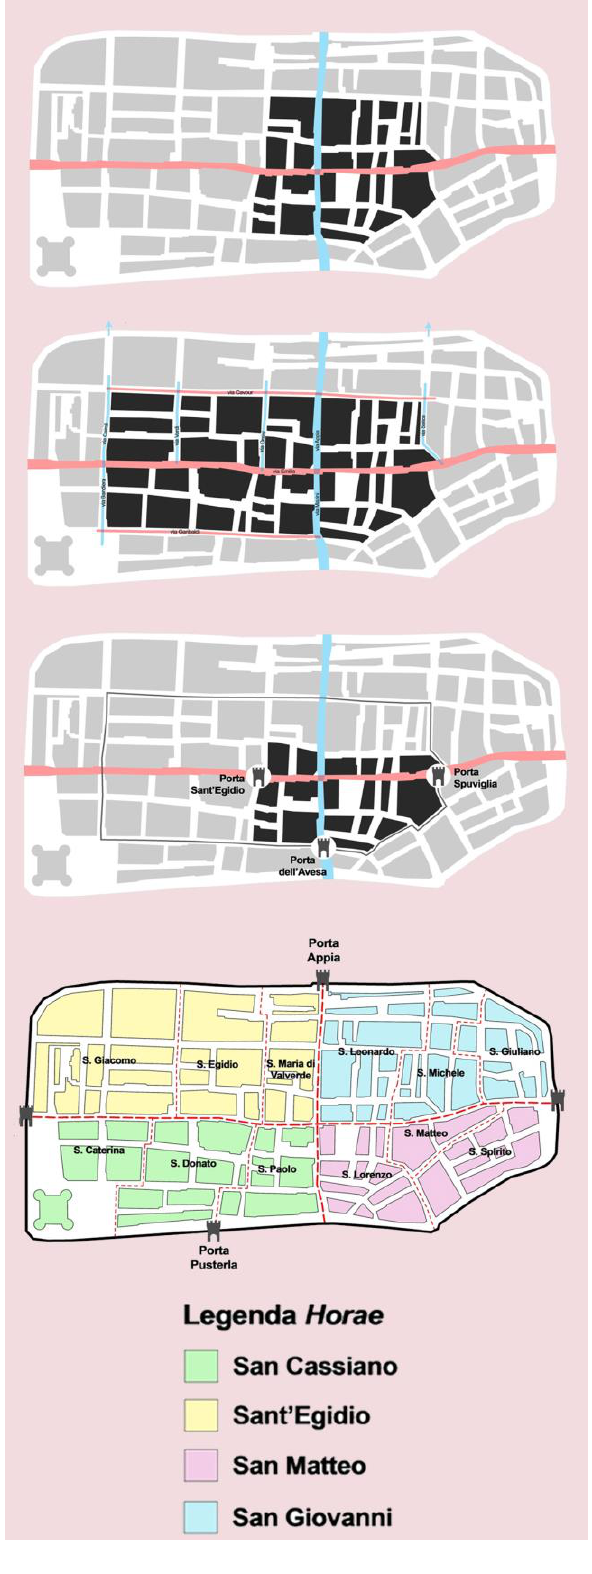
Figure 2. Evolution of the urban layout of Imola; from top to bottom: III century BC, I century BC, XI and XIV century AD (drawings by Laura